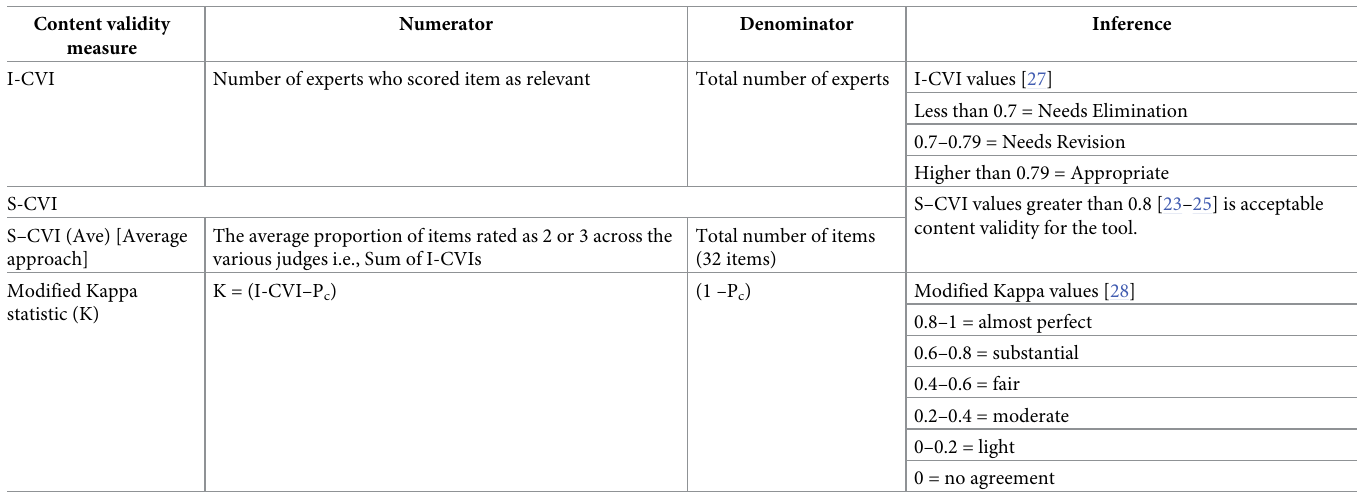
Table 1. Assessment of content